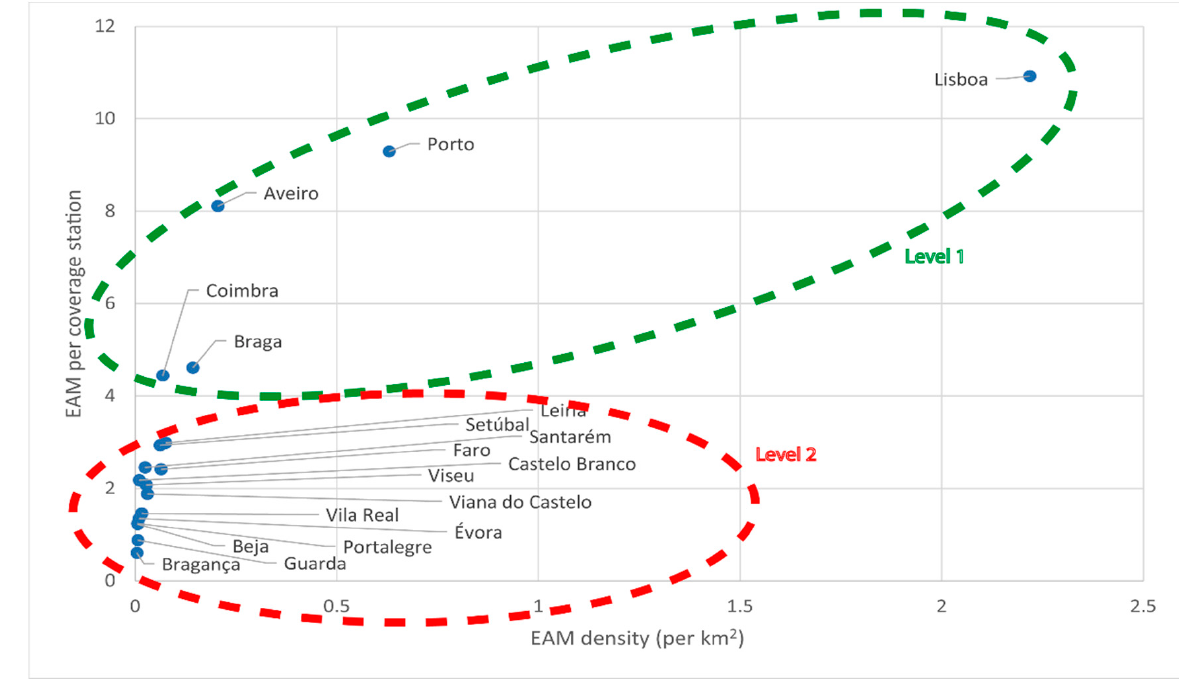
Figure 14. Districts with greater propensity according to the SERA model.